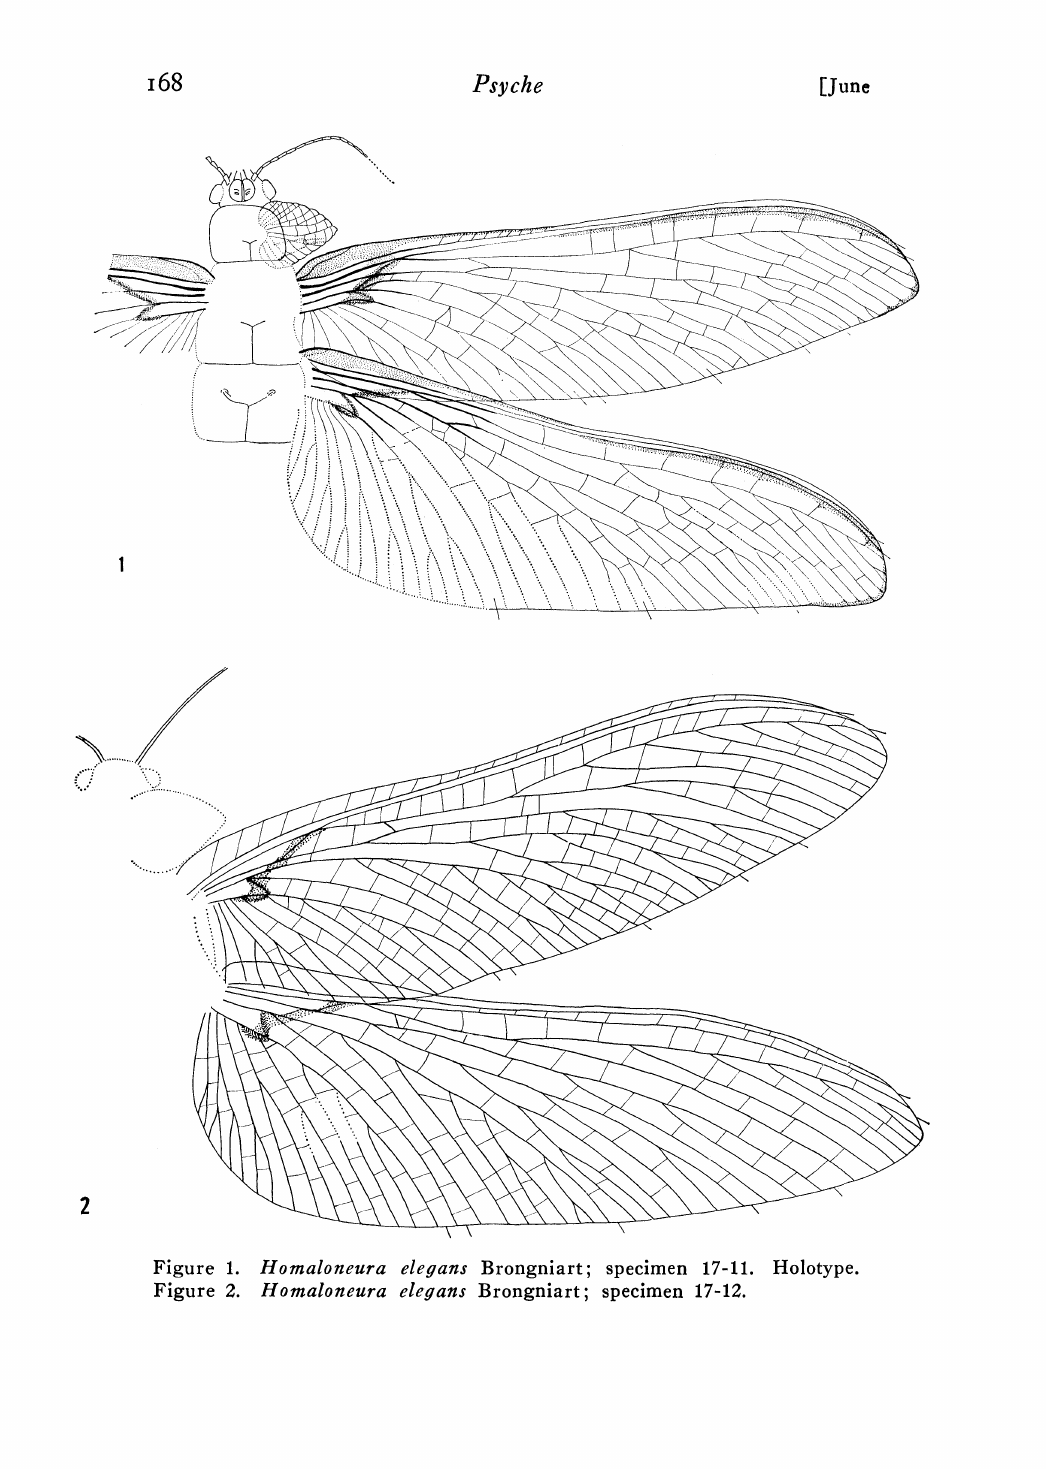
Figure 1. Homaloneura elegans Brongniart; specimen 17-11. Holotype. Figure 2. Homaloneura elegans Brongniart; specimen